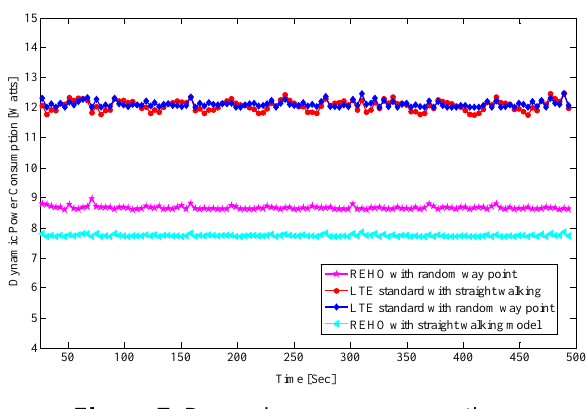
Figure 7. Dynamic power consumption